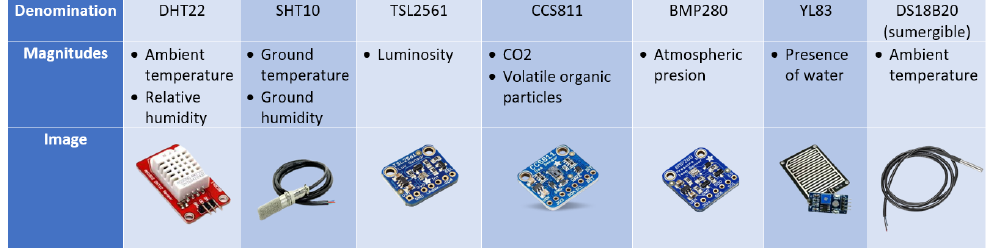
Figure 4. Selected sensors for the